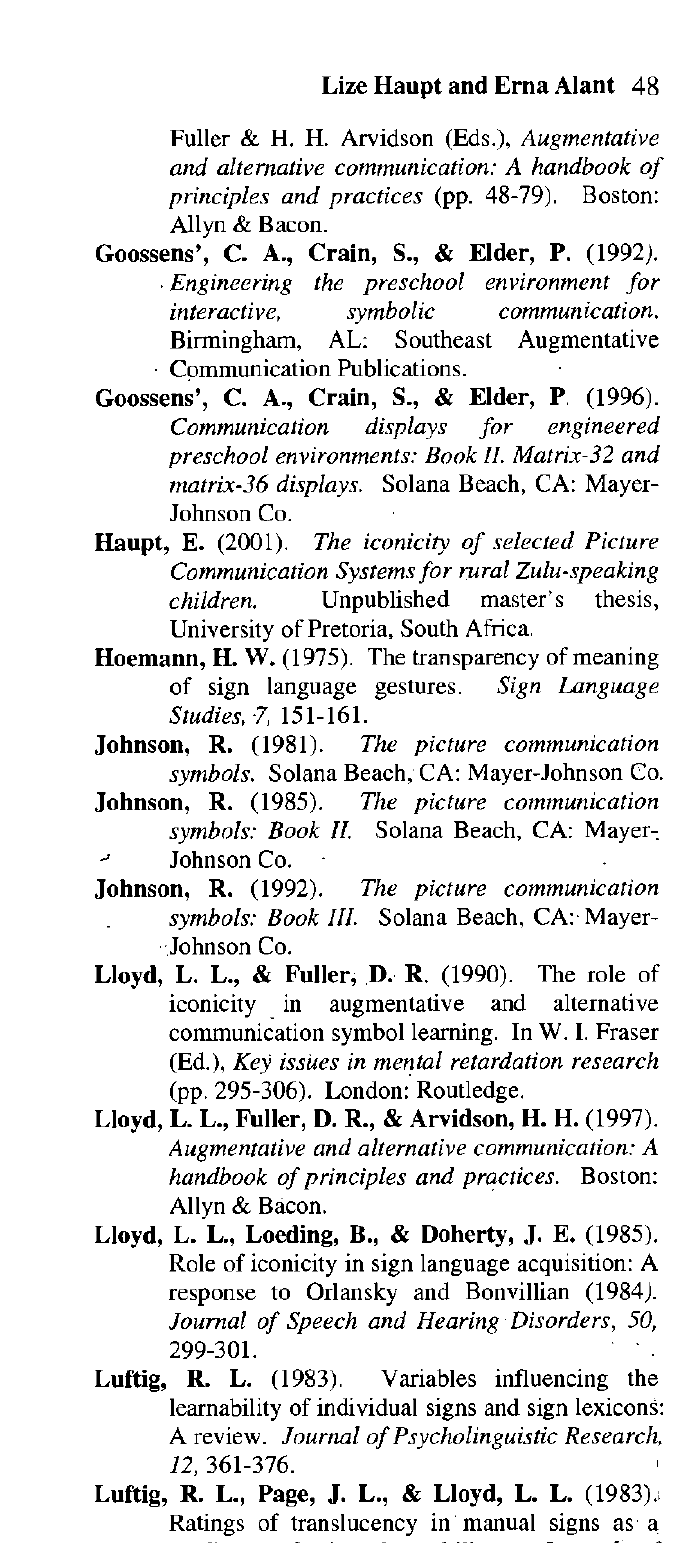
Johnson, R. (1985). symbols: Book II. Solana Beach, CA: Mayer- Johnson Co. Johnson, R. (1992). symbols: Book III. Solana Beach, CA: Mayer- Johnson